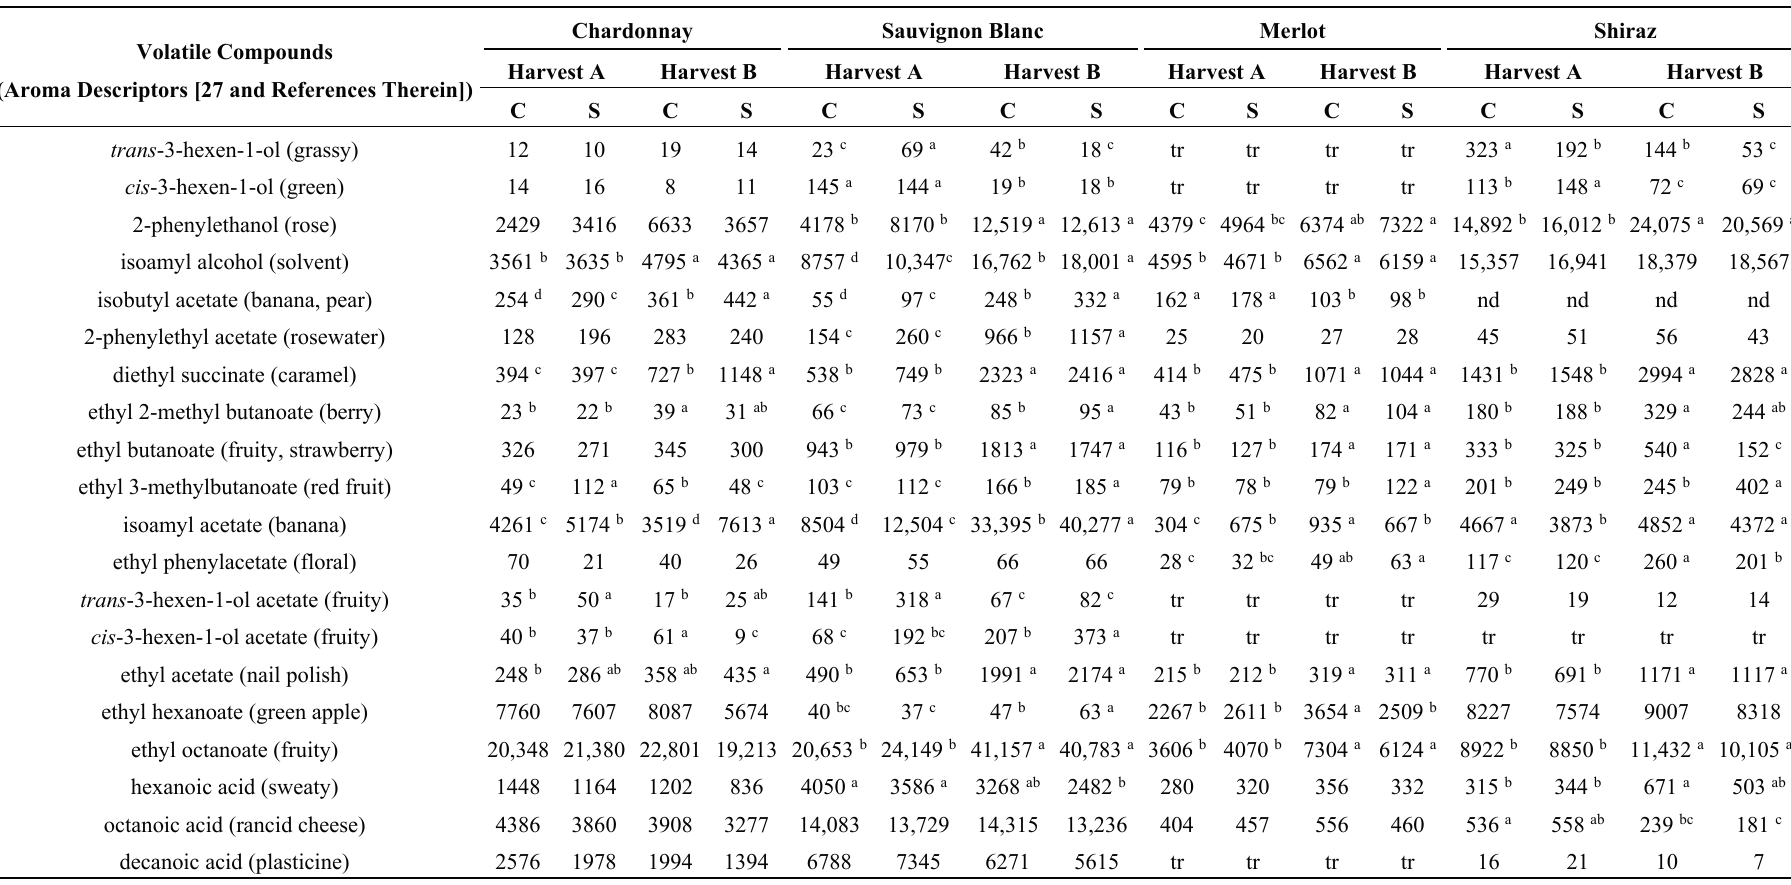
Table 4. Relative peak areas of selected volatiles detected in control and smoke-affected Chardonnay, Sauvignon Blanc, Merlot and Shiraz wines. Volatile